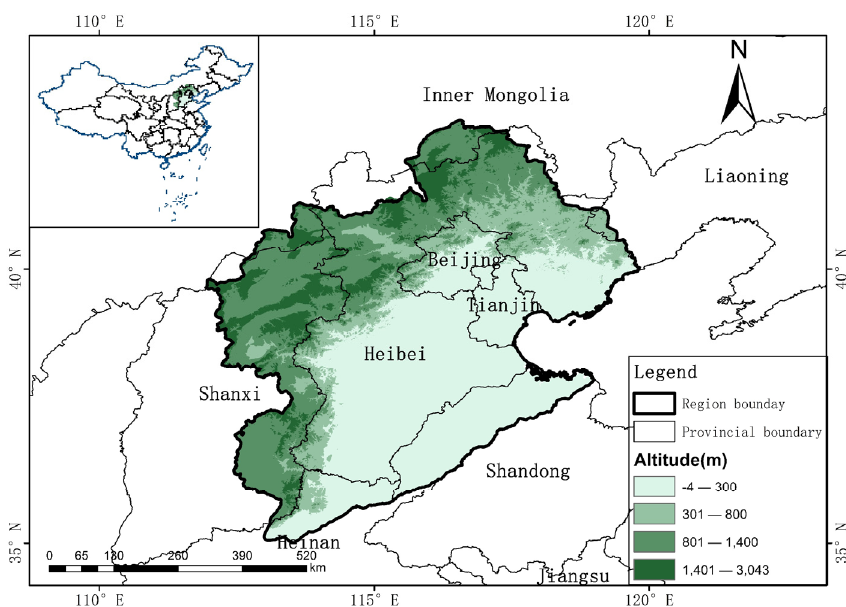
Figure 1. Geographical location map of the Haihe River Basin.